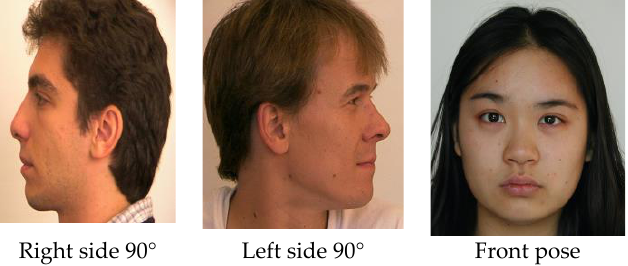
Figure 3. Estimation of the head pose for unknown images for different illumination conditions .